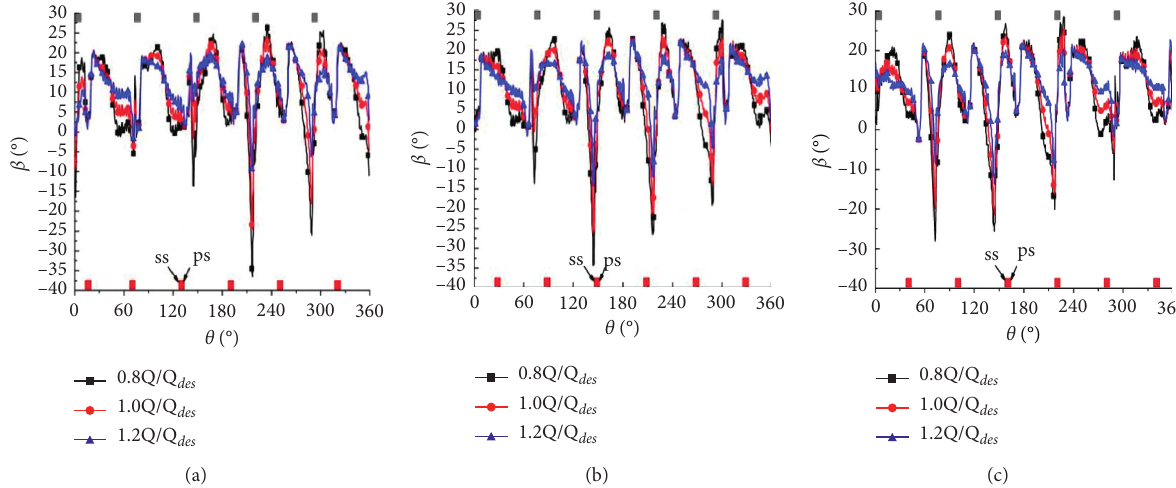
Figure 7: Different flow rates, different moments, the relative liquid flow angle distribution at the outlet of the impeller Z � 0. (a) t